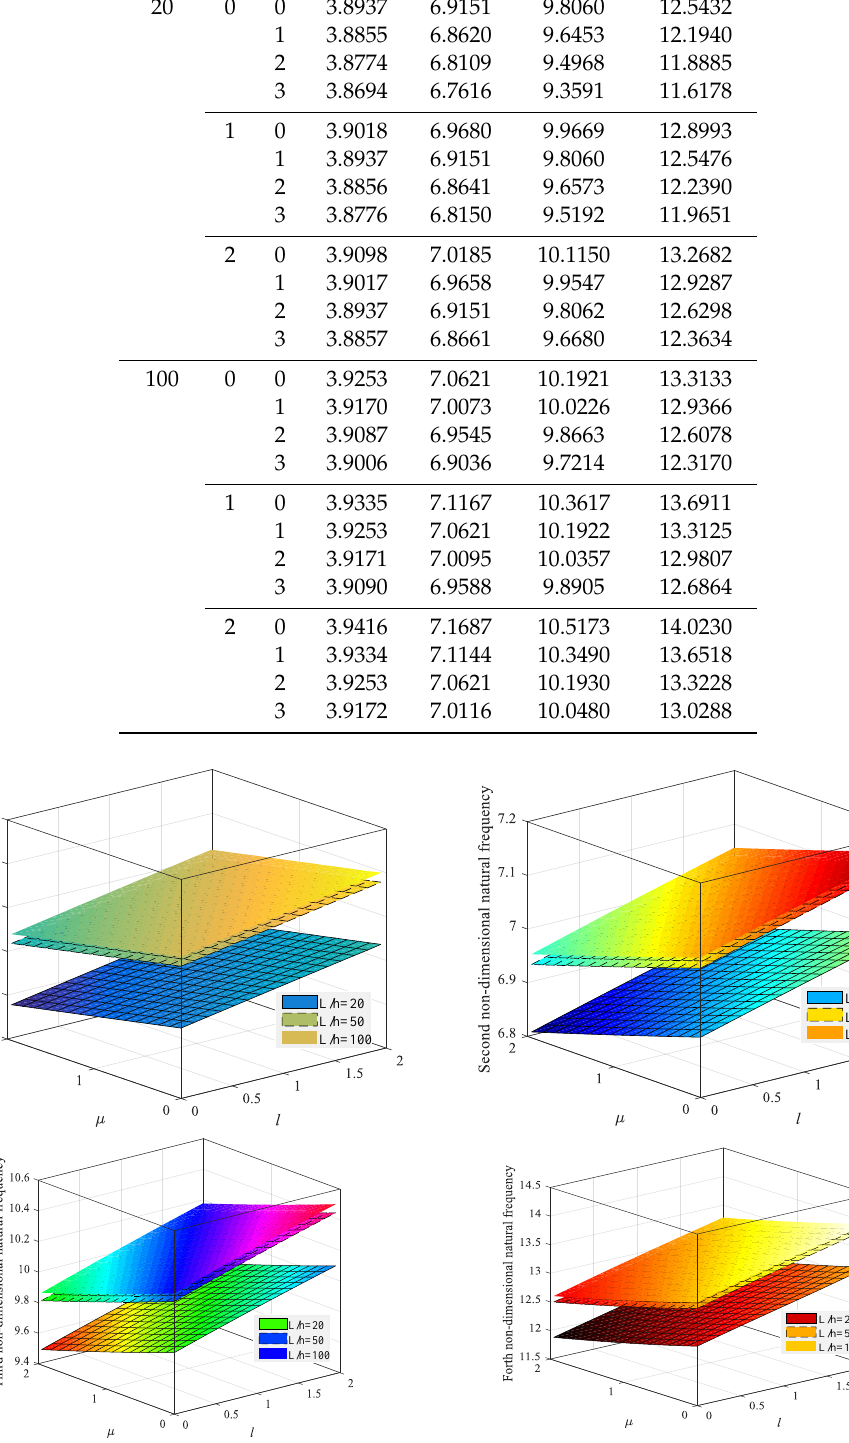
Figure 3. Variation of the first four natural frequencies for different L/h and small-scale parameters (clamped-simply supported nanobeam).